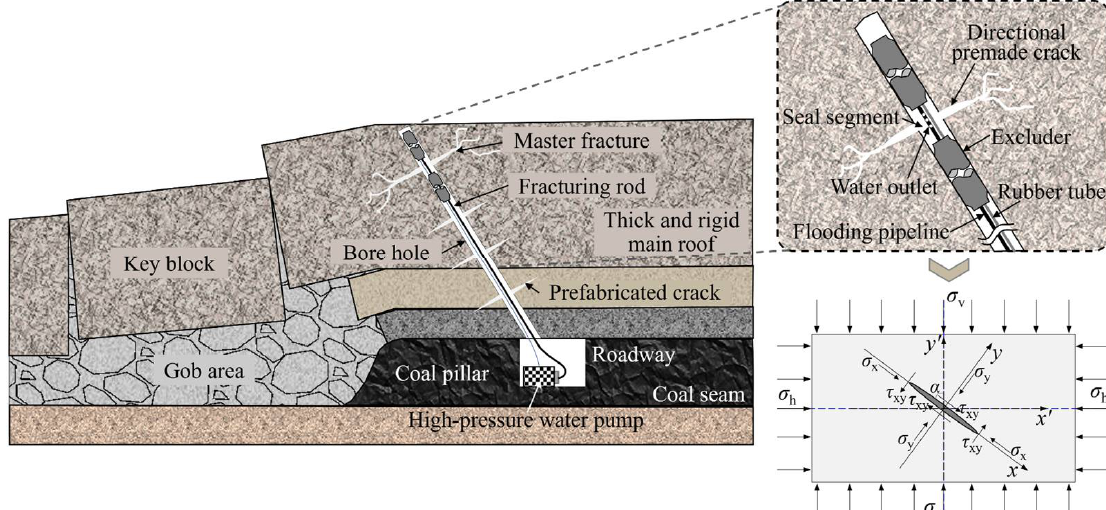
Figure 6. Principle of hydraulic fracturing rock.